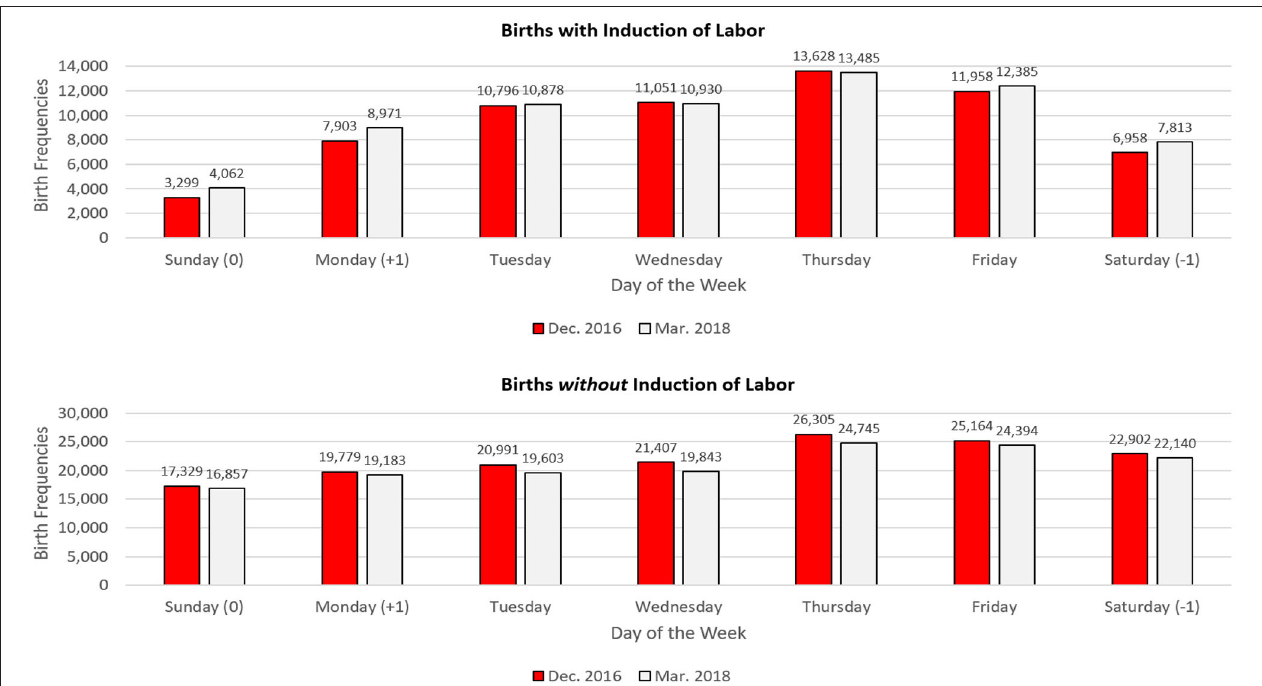
FIGURE 8 | Births in December 2016 and March 2018 by day of the week. The day of the week of Christmas Day (Sunday) is marked with a zero. Saturday (the day of the week of Christmas Eve) is marked − 1, and Monday (the day of the week of December 26) is marked + 1. Recall that March 2018 has 31 days and began on the same day of the week as December 2016.